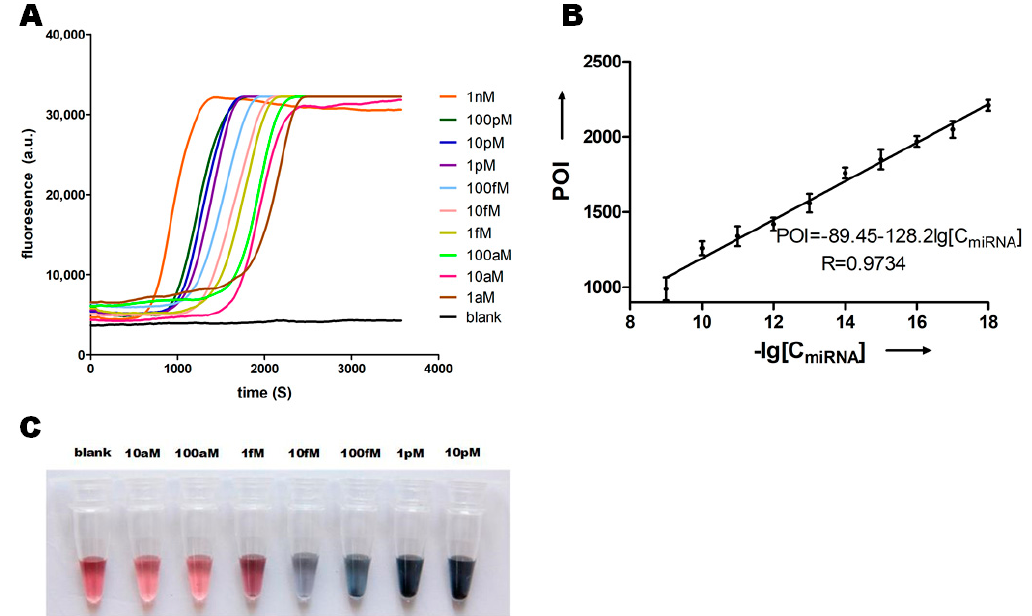
Figure 4. Effect of Vent (exo-) polymerase and Nt.BstNBI nickase on EXPAR. Under the same concentration of one enzyme, the maximal slope of the S-shaped curve increases correspondingly with the concentration of the other enzyme. Considering the cost-effectiveness factor and the excellent experimental performance, 0.06 U/ µ L polymerase and 0.3 U/ µ L nickase were selected for the following EXPAR.